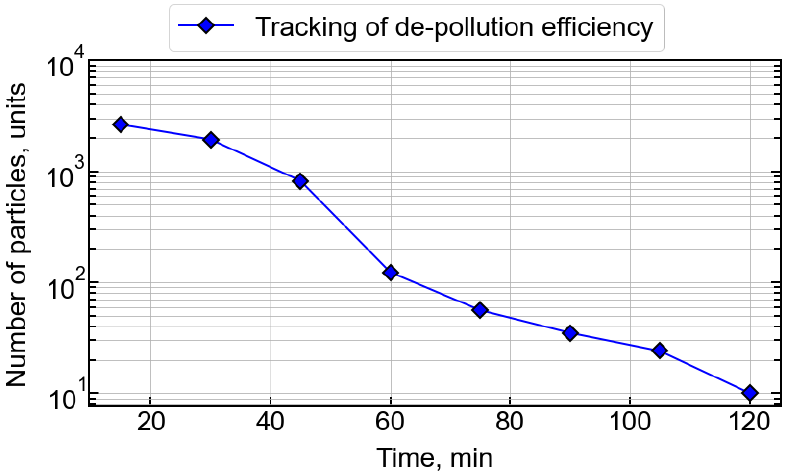
Figure 11. Laser confocal images, optical image, and topography of the Nb sample after Step 2.